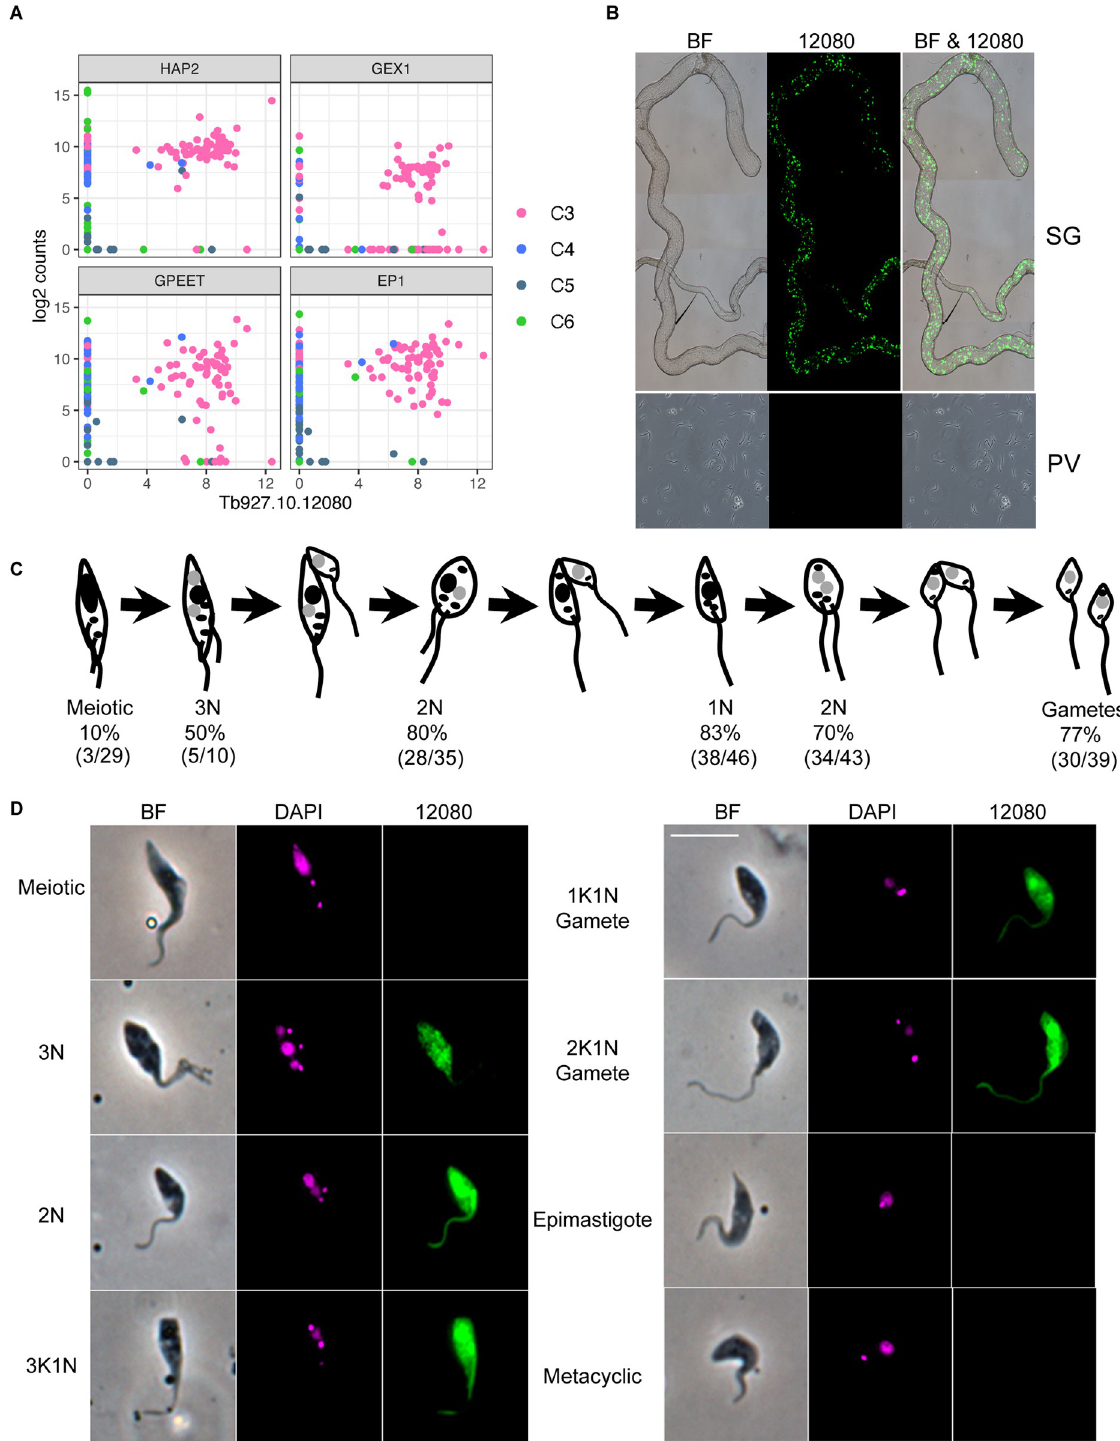
Fig 6. Expression of Tb927.10.12080 coincides with sexual forms. (A) Co-expression of Tb927.10.12080 with genes encoding HAP2 and GEX1, proteins associated with gamete and nuclear fusion in eukaryotes, and the surface antigen genes GPEET and EP1; co-expression is seen in a subset of cells from C3 (Fig 1D). (B) T . brucei strain 1738 GFP::Tb927.10.12080–3’UTR transcribed from the procyclin promotor in the salivary gland (SG) and proventricular forms (PV). (C) Diagram showing major cell types observed during meiosis in T . brucei (adapted from [10]); nuclei are shown in black (4C or 2C DNA contents) or grey (1C, haploid) and kinetoplasts are shown as smaller black dots.